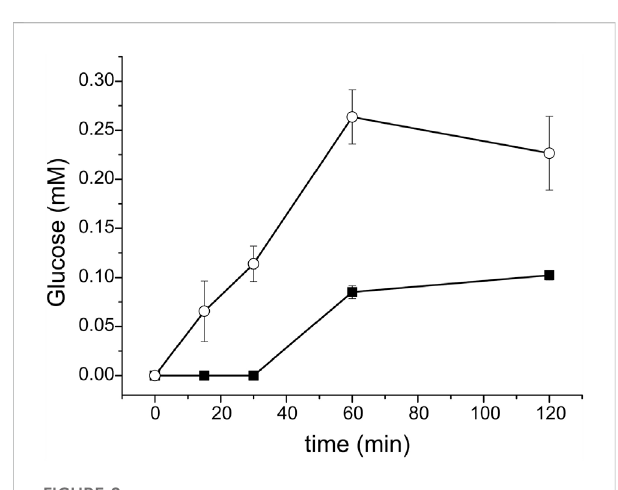
FIGURE 8 Glucose released from PASC arsenolysis with Ral CDP (squares) and Ral CDP-CBM37